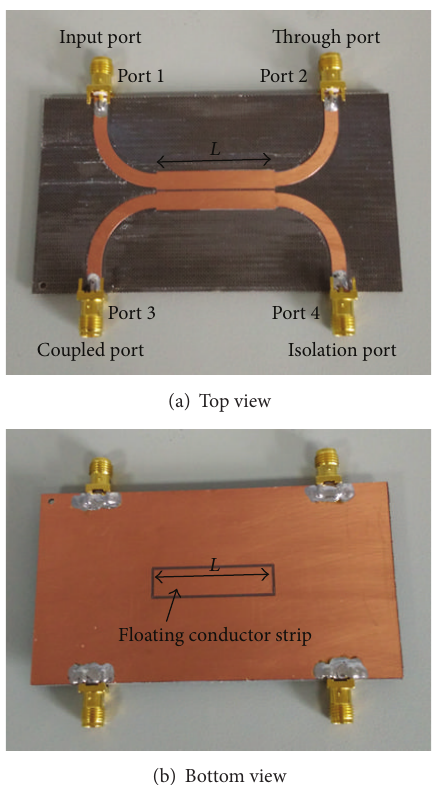
Figure 5: Photograph of the fabricated 7dB coupler configured with the PCMLFGPC.